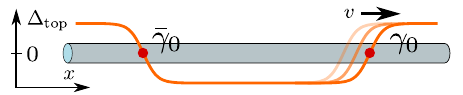
FIG. 1. Schematic illustration of a moving Majorana bound due to translation of a topological domain state (cid:4) 0